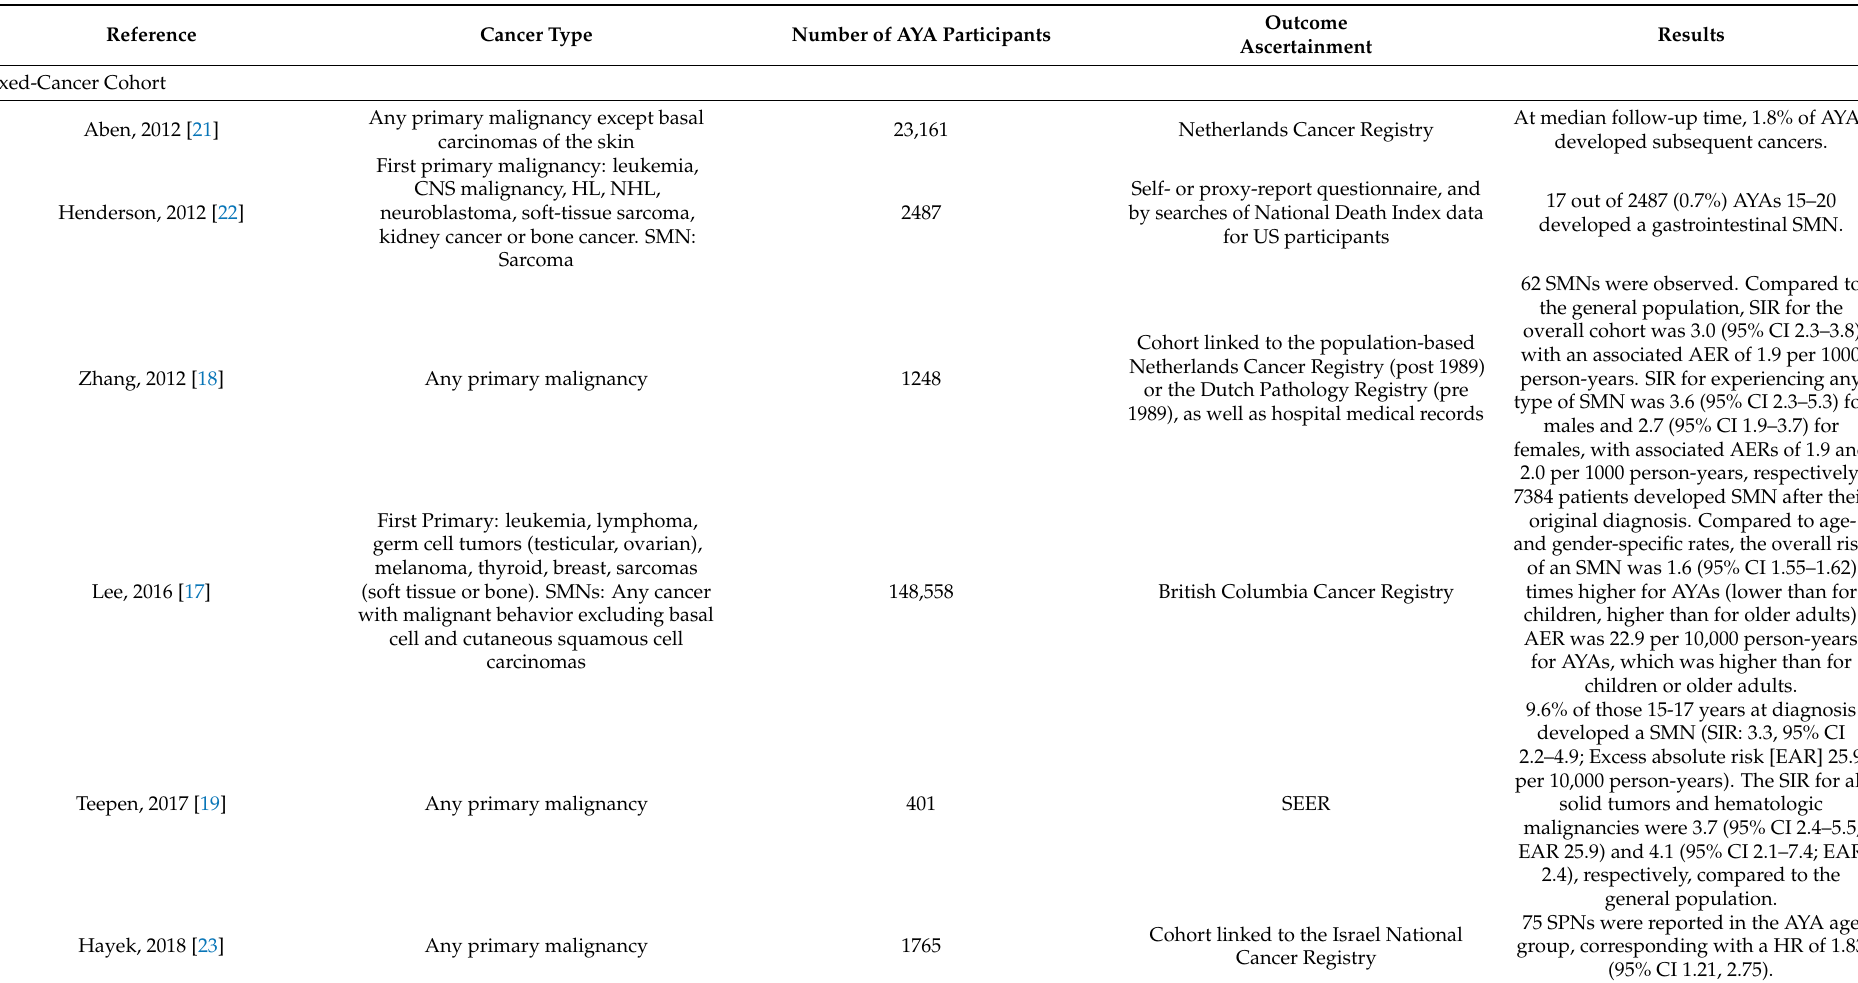
Table 1. The burden of subsequent malignant neoplasms (SMNs) among adolescent and young adult cancer survivors by tumor group (n =